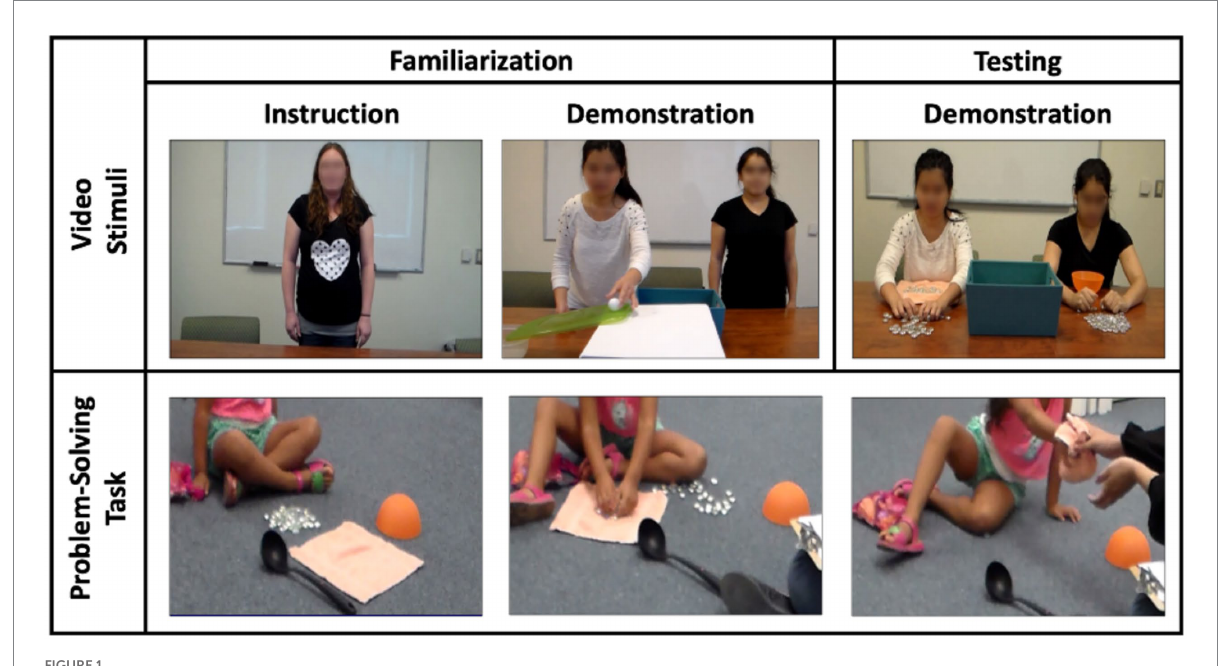
FIGURE 1 Stimulus video (top) and problem-solving task procedure